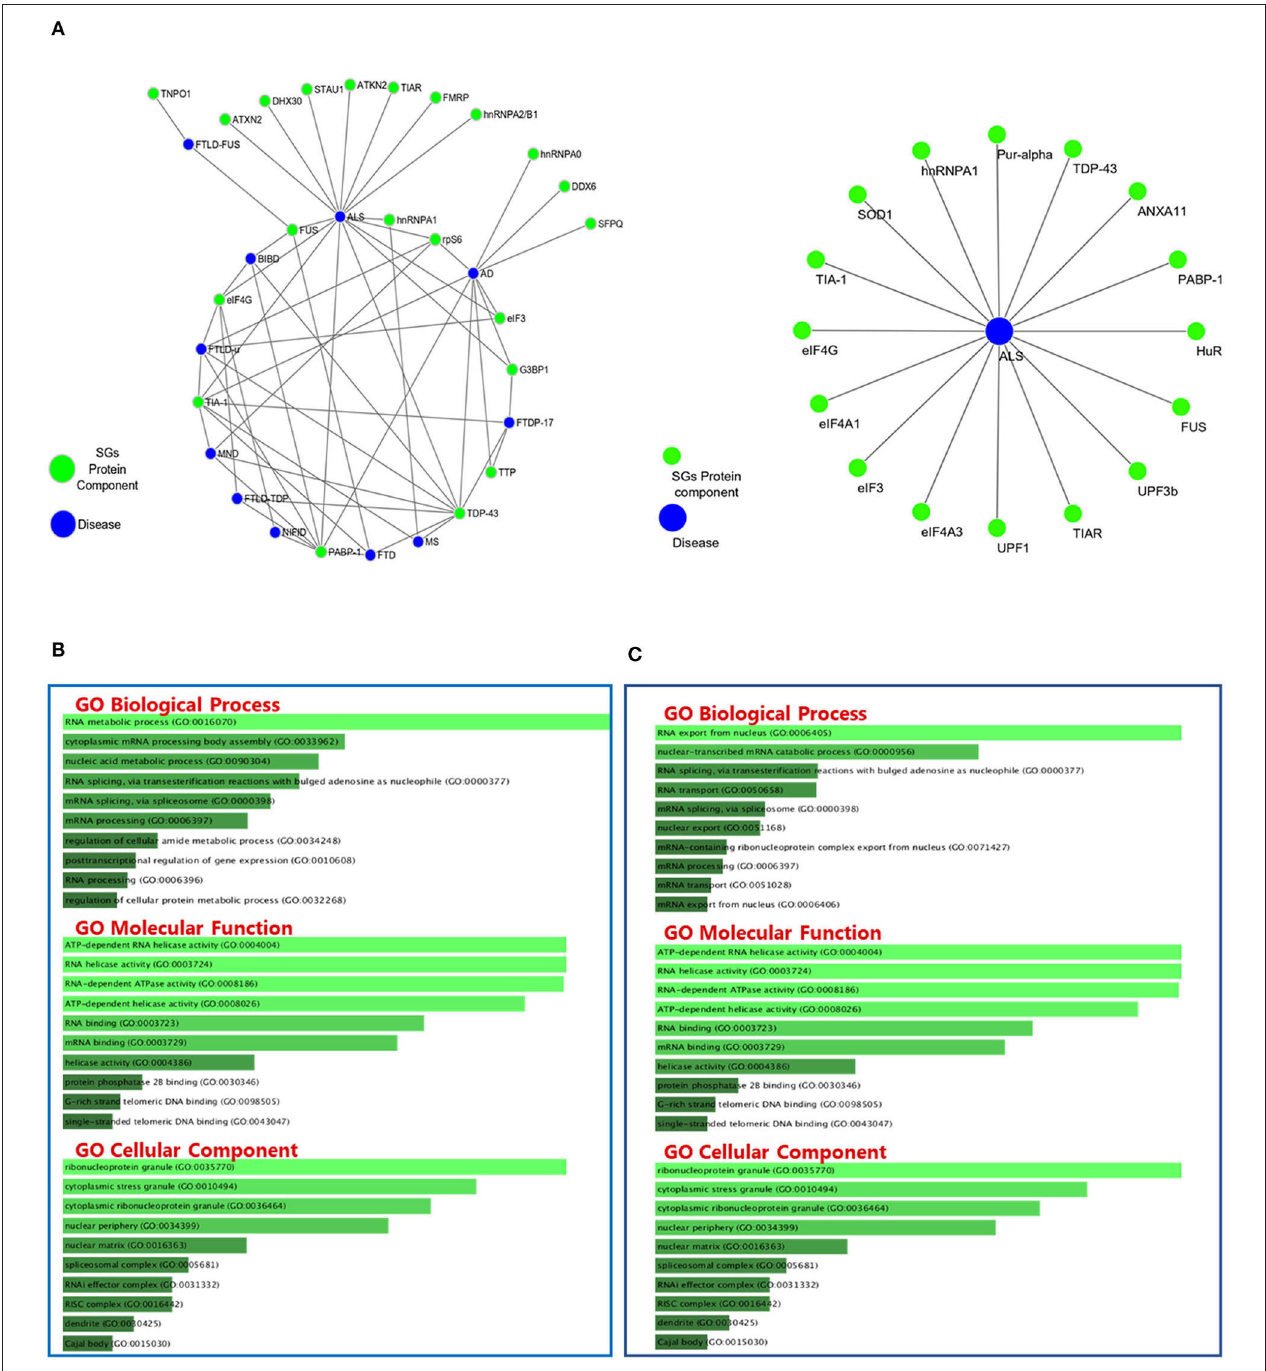
FIGURE 2 | Protein-Protein Interactions and Top 10 GO analysis of target genes in SGs protein components in neurodegenerative disease. The network of neurodegenerative diseases with protein components of SGs and their interactions. (A) Gene ontology analysis of the genes in Table 2 (B) and Table 3 (C) has been performed. The length of each bar represents the degree of significance in that particular category sorted by p- value. Note that the lower the color intensity of the bars, the greater the relationship with that